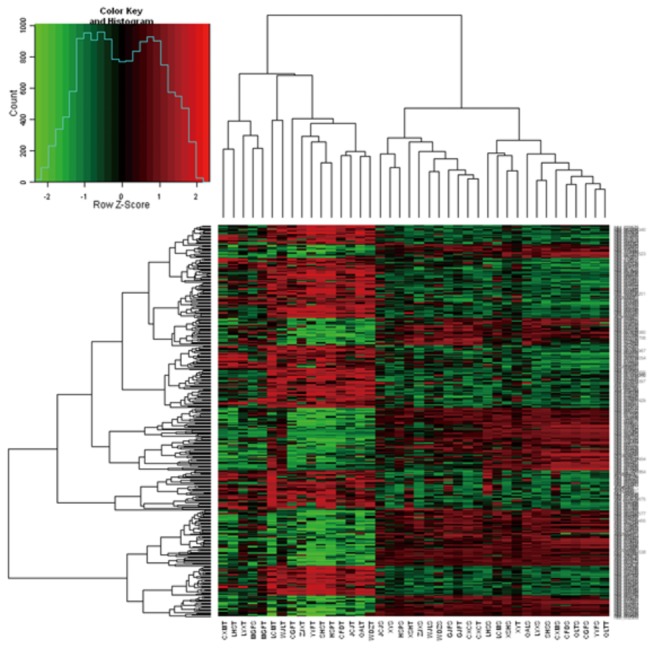
Expression data of genes from tumors and non-tumor specimens of 20 gastric cancer patients hybridized using the custom microarray of differential expression genes between two groups.Each column represents a sample and each row a gene. The character of “T” refers to tumor and the character of “S” refers to premalignant tissue in sample names. The expressions of genes between two groups have significant differences, fold change log2 >=1 or <= -1, P<0.01.